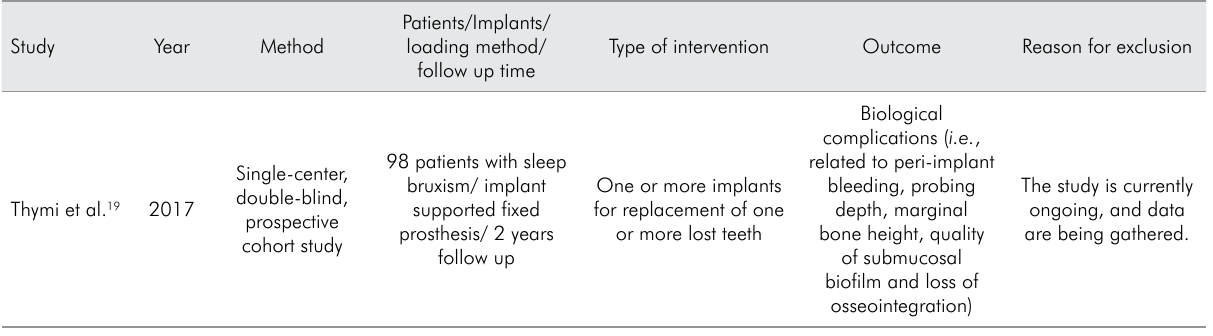
Table 3. Study characteristics of the clinical studies excluded.